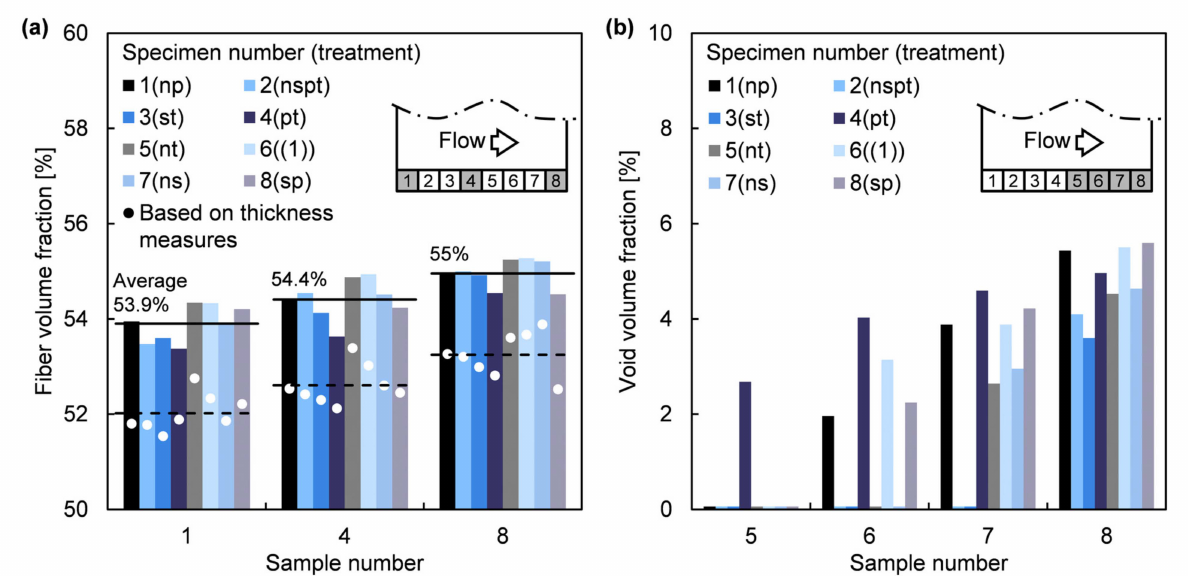
Figure 7. Results of the loss on ignition method: ( a ) Fiber volume fraction, v (cid:48)